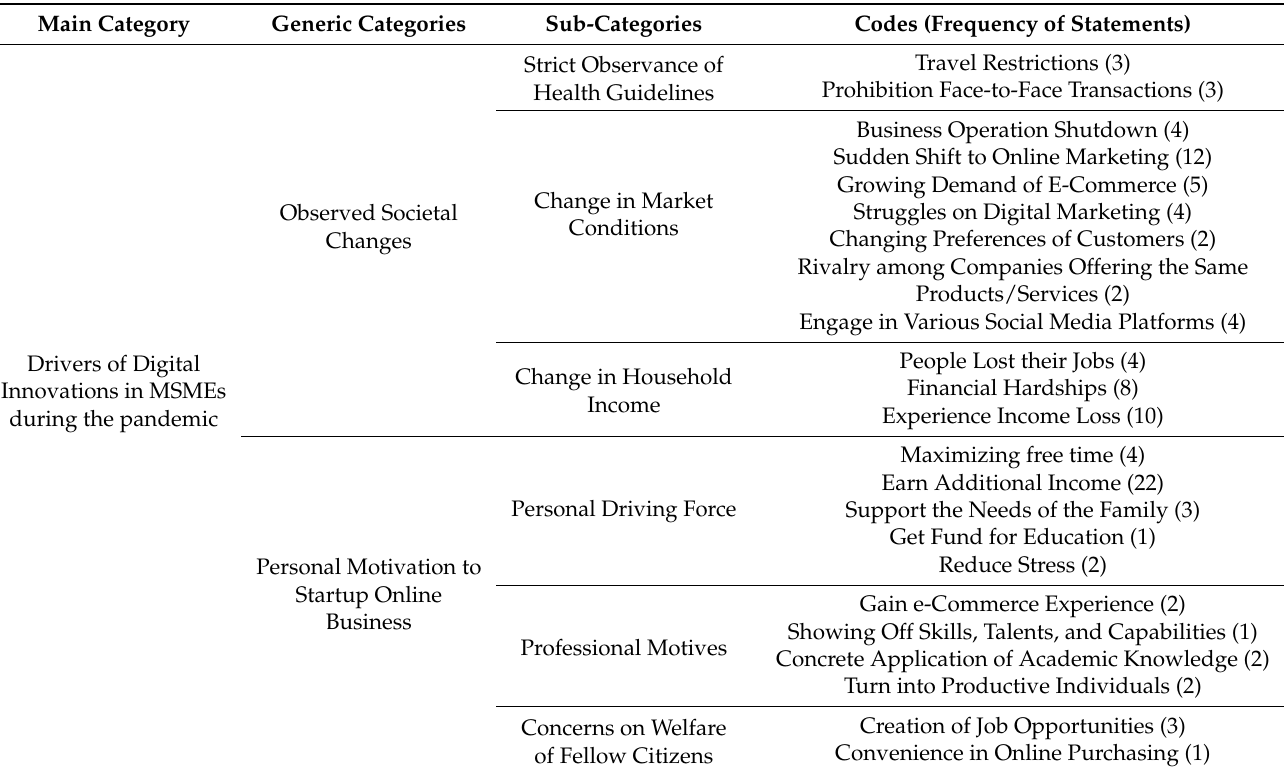
Table 1. Abstraction results of young entrepreneurs’ lived experiences on digital entrepreneurship during the pandemic (see Appendix B Table A2 for the Summary of Generated Codes and the Significant